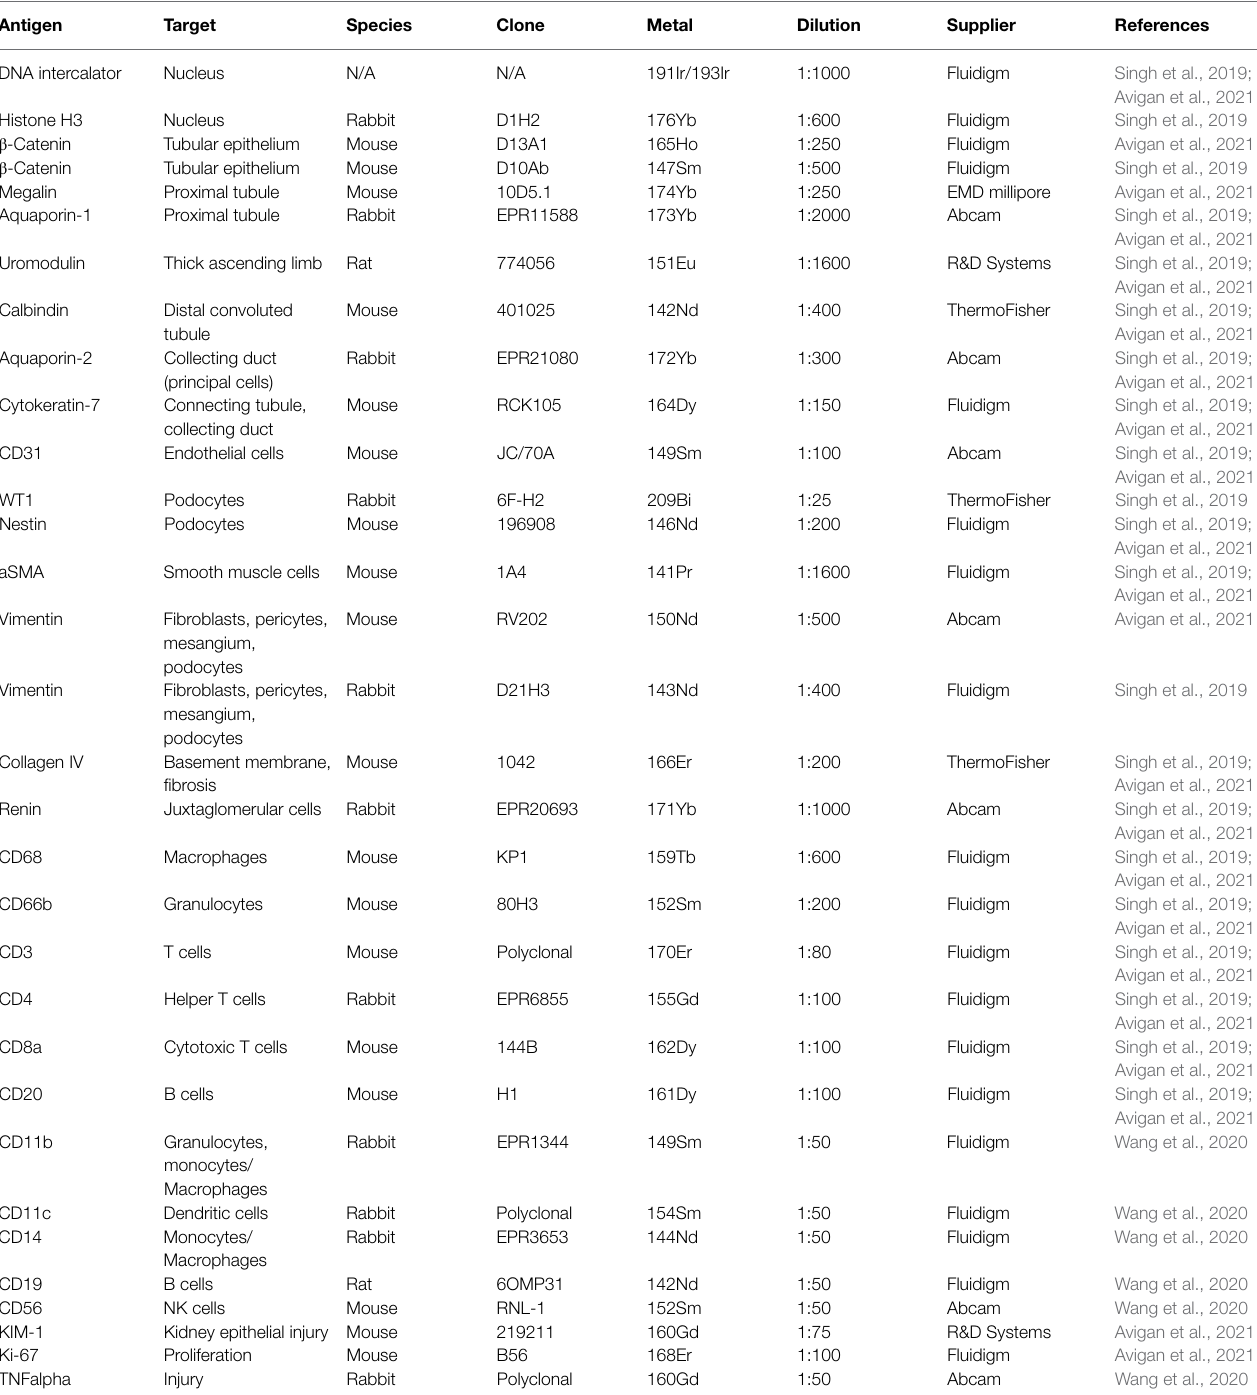
TABLE 1 | List of antibodies used on human kidney